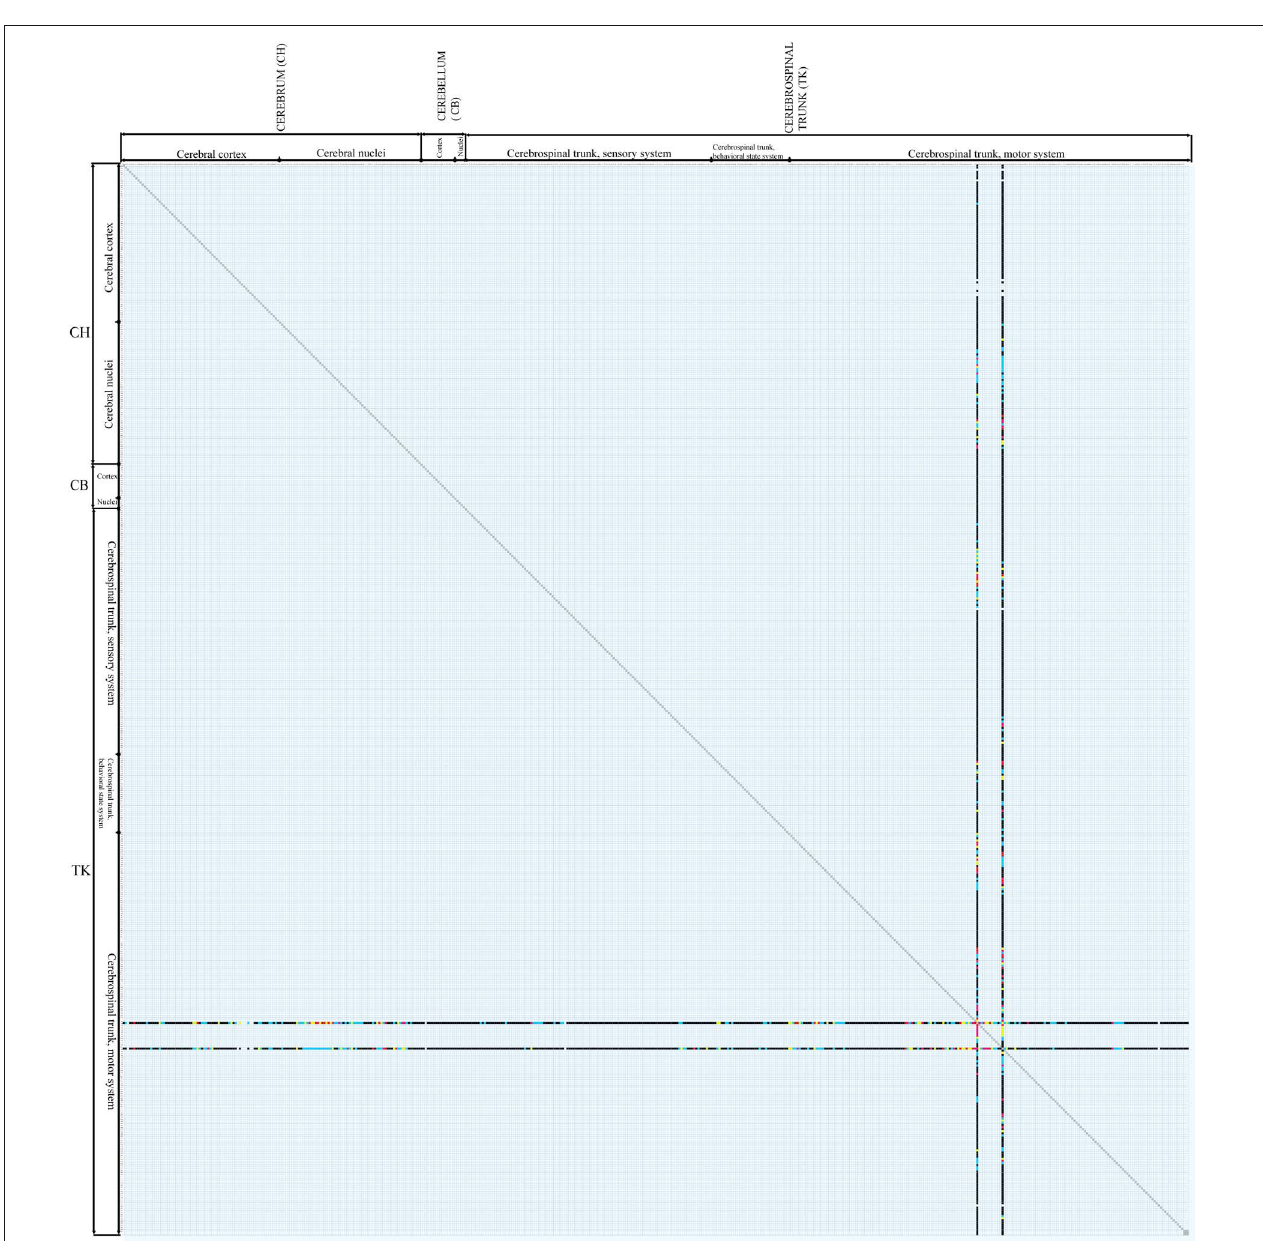
retrograde tracer (CTb) data from the same two injection sites (in different animals, in this case, though results were plotted on the same series of reference atlas level plates in the original publication). A large-scale, systematic series of coinjection sites throughout the central nervous system would gradually fill in the entire matrix. Attempts to do this in the mouse have begun in the last two